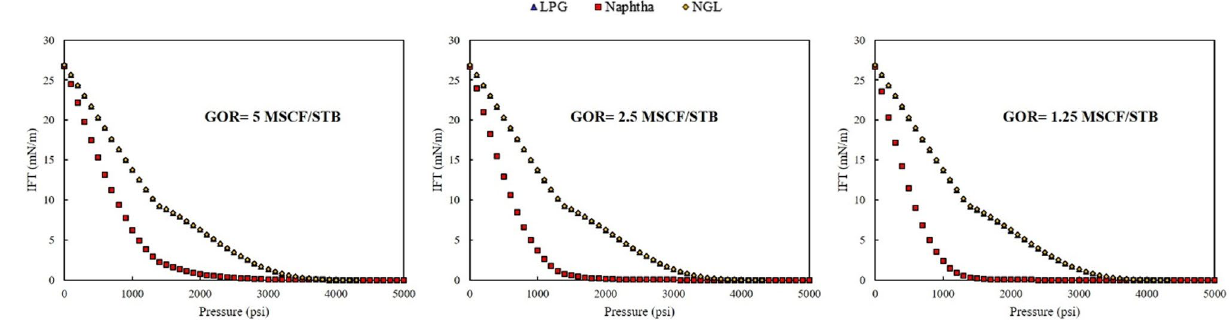
Figure 4. IFT of rich gas-oil system for three GORs of 1.25, 2.5, and 5 Mscf/STB.